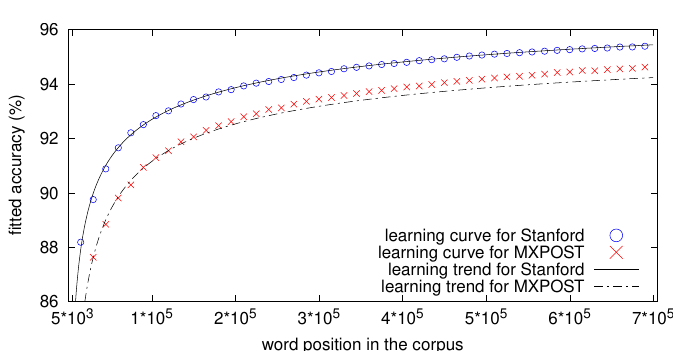
learning curve for Stanford learning curve for MXPOST learning trend for Stanford learning trend for MXPOST